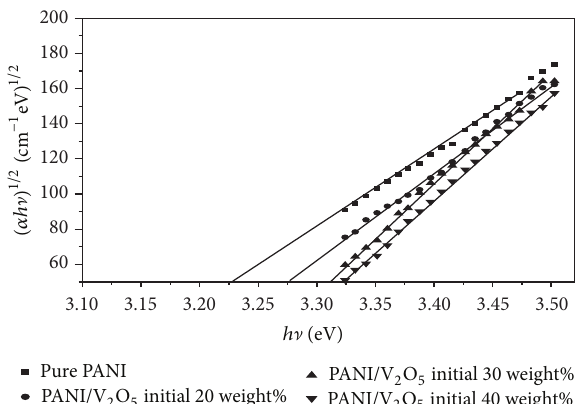
Figure 8: (𝛼ℎ ] ) 1/2 versus photon energy of pure PANI and PANI/V 2 O 5 composites (different weight